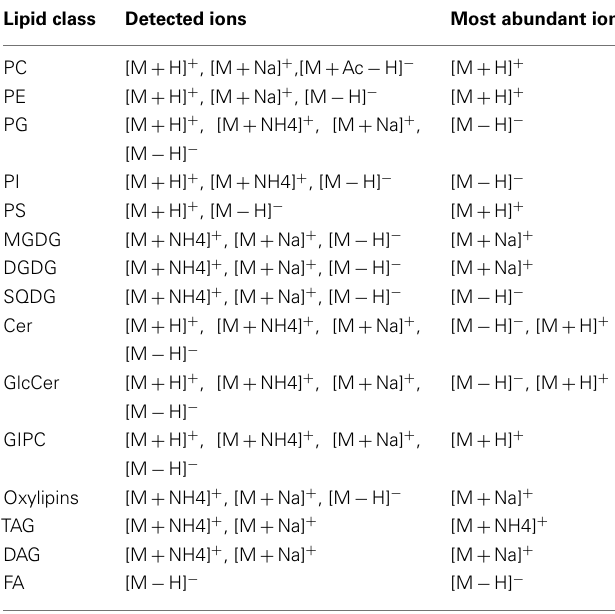
Table 1 | Ionization adducts of the detected lipid classes within the UPLC chromatograms.